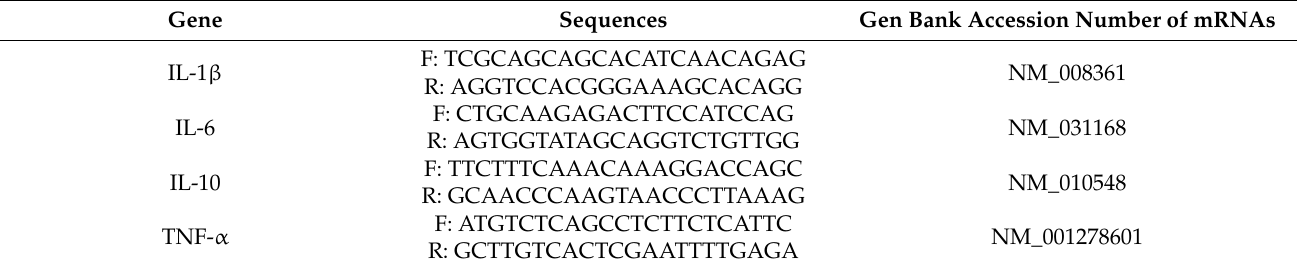
Table 1. Target Gene primer sequences designed for